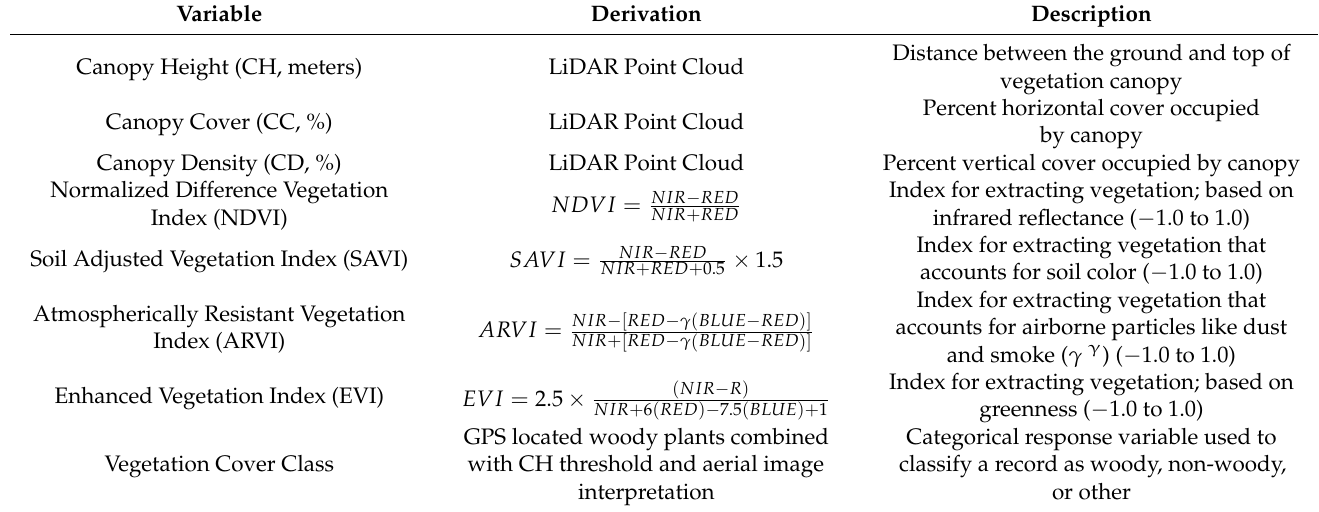
Table 2. List of variables used for this study. Five statistics for each variable were calculated (mini- mum, maximum, mean, range, and median pixel value for each polygon) for a total of 35 numerical predictor variables and a single response